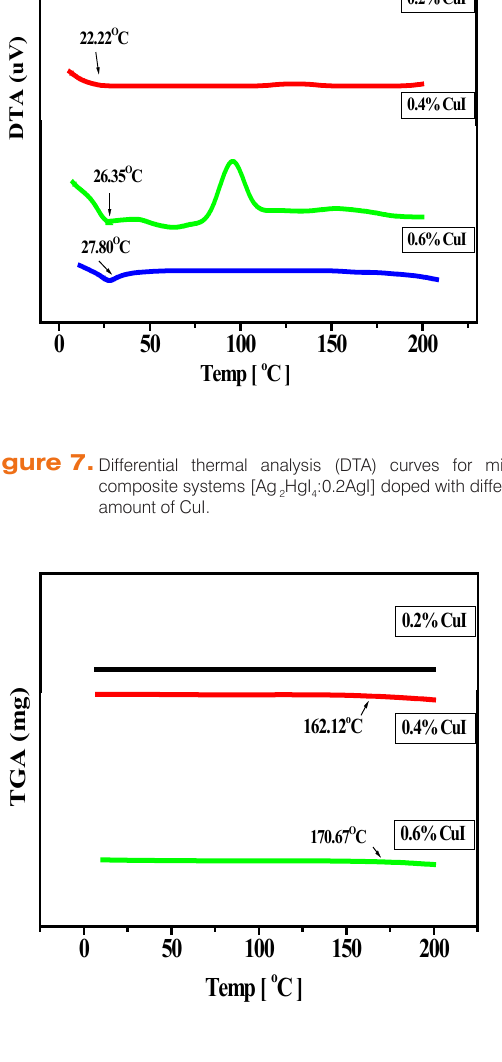
Figure 8. Thermo-gravimetric analysis (TGA) curves for mixed composite systems [Ag amount of